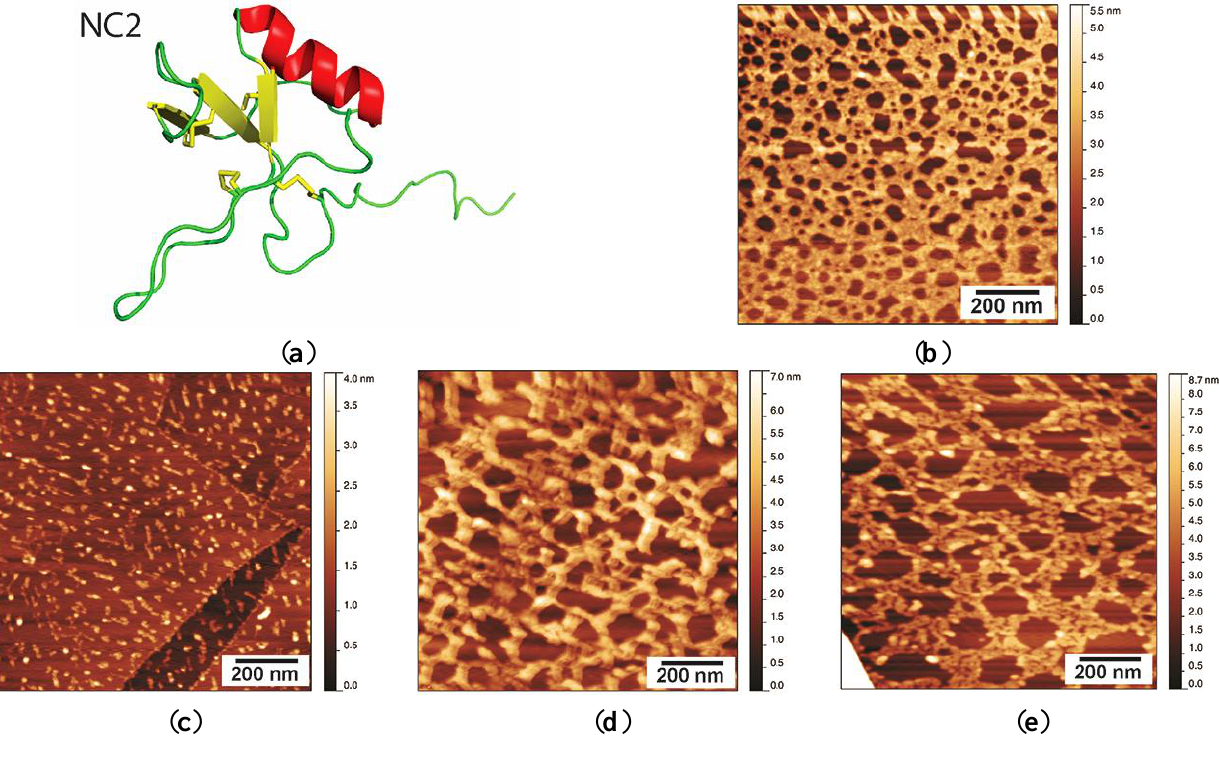
Figure 5. ( a ) Ribbon representation of the solution structure of NC2, prepared from PDB Entry 4AOG using PyMol [24]; ( b ) NC2 layer washed with MQW for 5 min, displaying a protein network with pores of 20–30 nm and a layer height of 1.5–2 nm; ( c ) NC2 layer after treatment with 60% ethanol for 5 min; ( d ) NC2 layer after treatment with 3 M NaOH; and ( e ) NC2 layer after treatment with 3 M